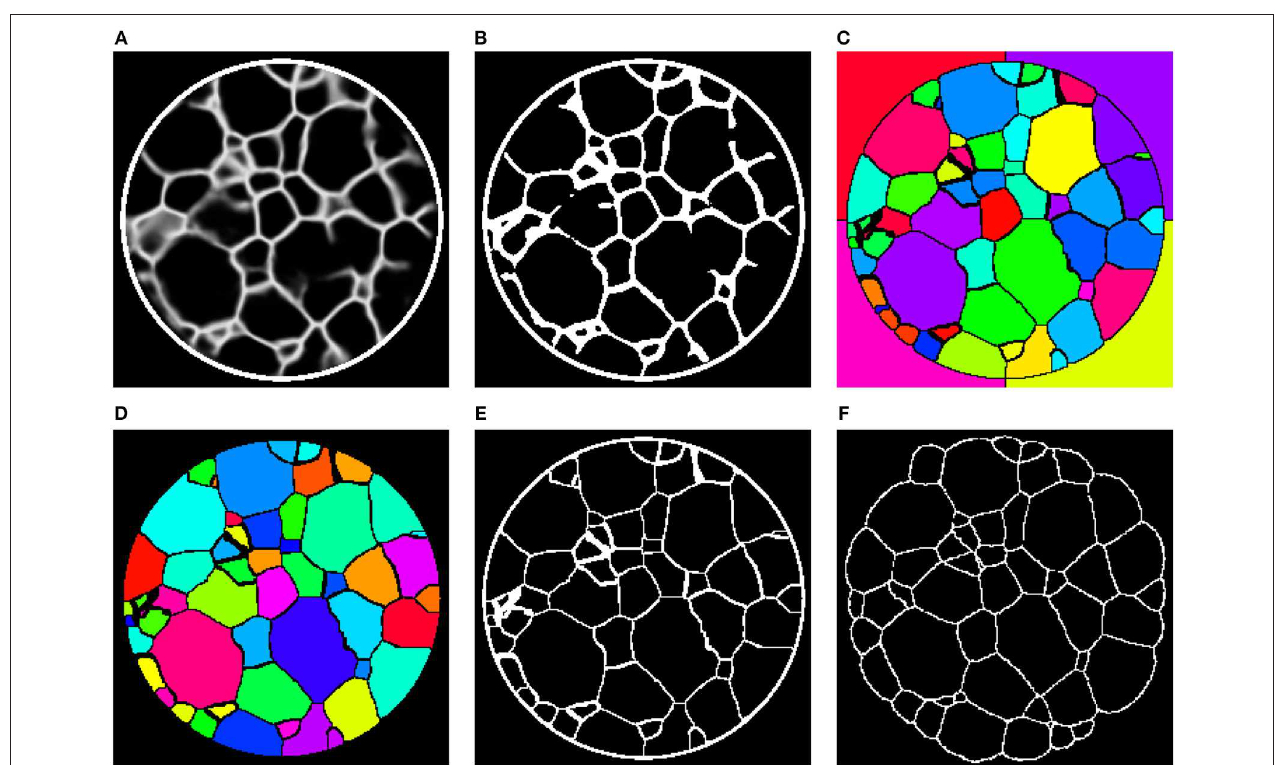
FIGURE 10 | (A) 2D slice through the 3D image ˆ L t obtained by preprocessing with the 3D U-Net. (B) Binarization of ˆ L t after applying a global threshold, followed by morphological closing. (C) Initial grain-wise segmentation obtained by a marker-based watershed segmentation. (D) Final segmentation after postprocessing. (E) Grain boundaries extracted from the segmentation in (D) . (F) Grain boundaries obtained by 3DXRD microscopy.